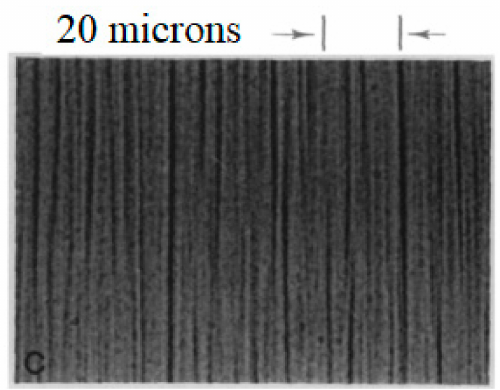
Figure 1. Typical photo [34] of the drop-like aggregates aligned along an applied magnetic